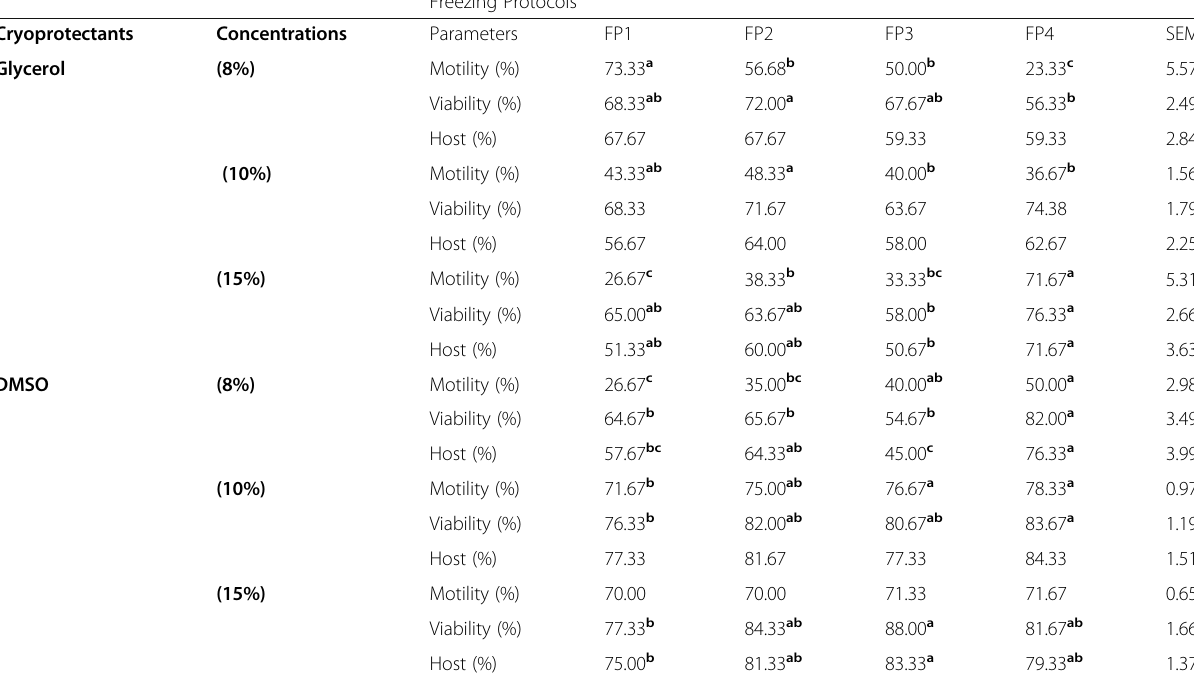
Table 2 Effects of freezing protocols on frozen thawed rooster semen cryopreserved with coconut water extender containing different concentrations of glycerol and DMSO